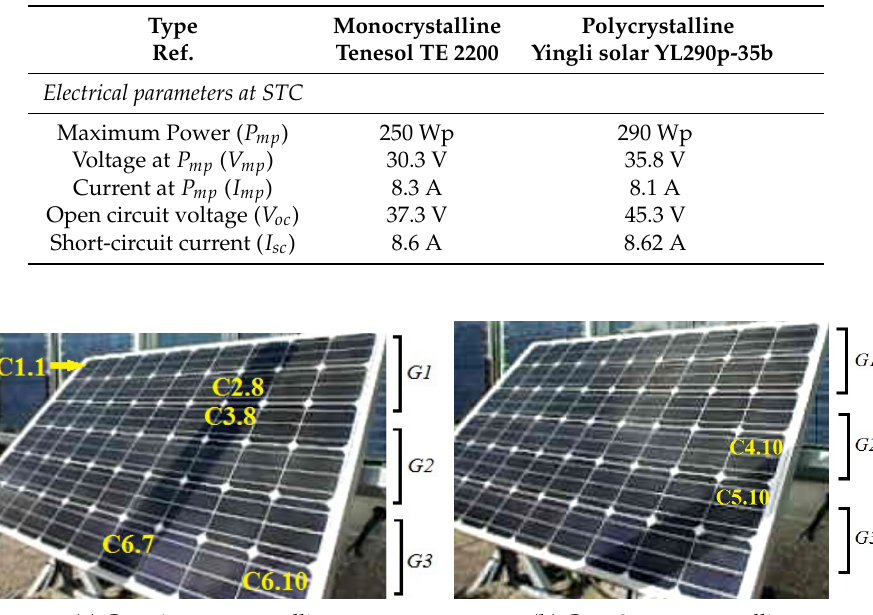
Table 4. Photovoltaic modules under testing.